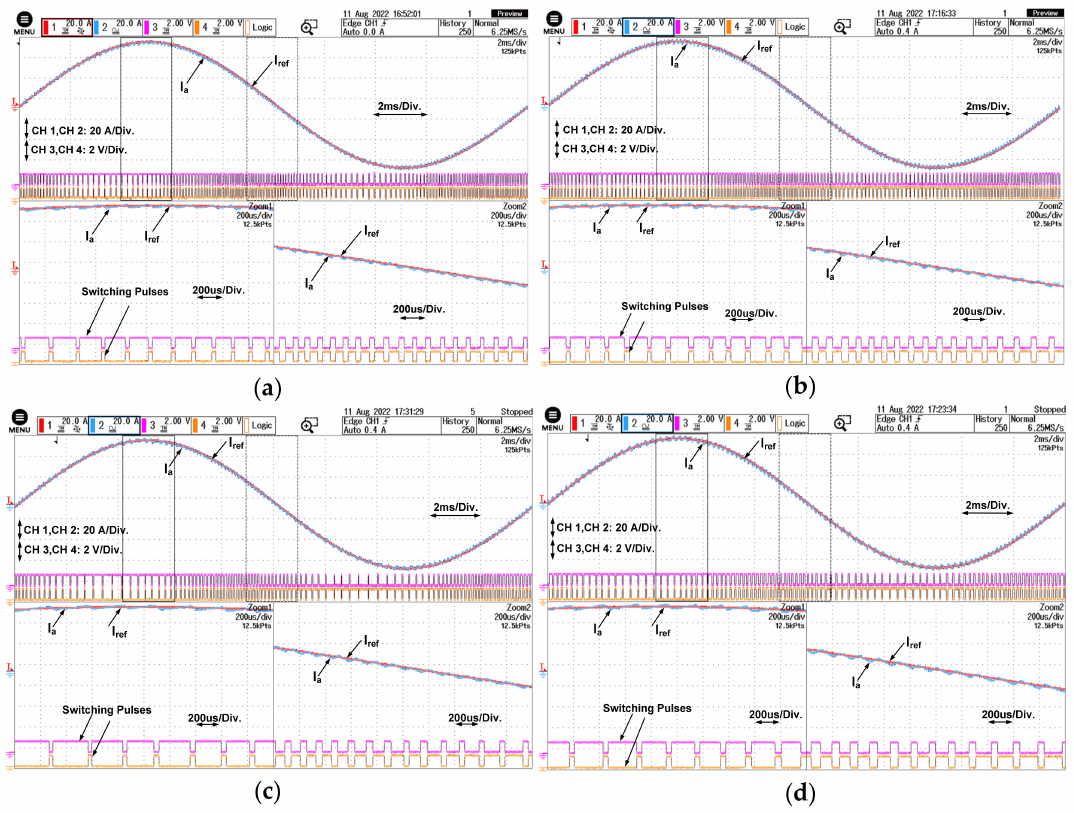
Figure 13. Experimental results showing I ref , I a , and switching pulses for ( a ) PSO-CHCC, ( b ) FBI-CHCC, ( c ) AOA-CHCC, and ( d )